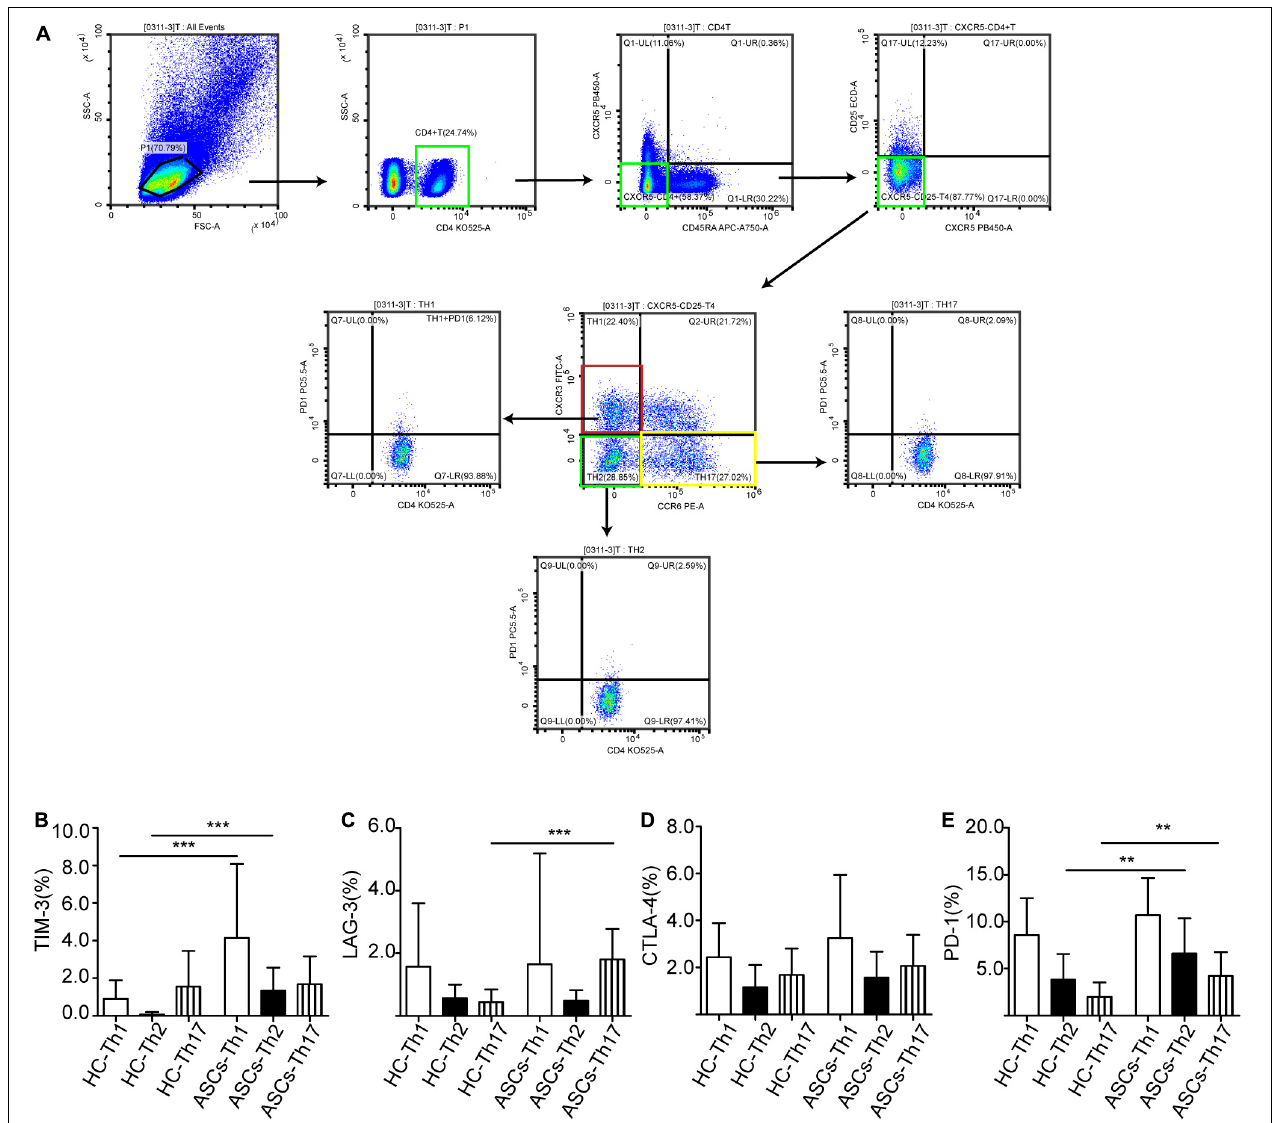
FIGURE 4 | CD4 + T cell subsets showed different levels of immune checkpoint molecules. (A) Analysis of CD4 + T cell subsets. (B) TIM-3 + expression on Th1, Th2, and Th17 cells. (C) LAG-3 + expression on Th1, Th2, and Th17 cells. (D) CTLA-4 + cells expressed on Th1, Th2, and Th17 cells. (E) PD-1 + expression on Th1, Th2, and Th17 cells. Data represent the mean ± SD. ** P < 0.01; *** P <